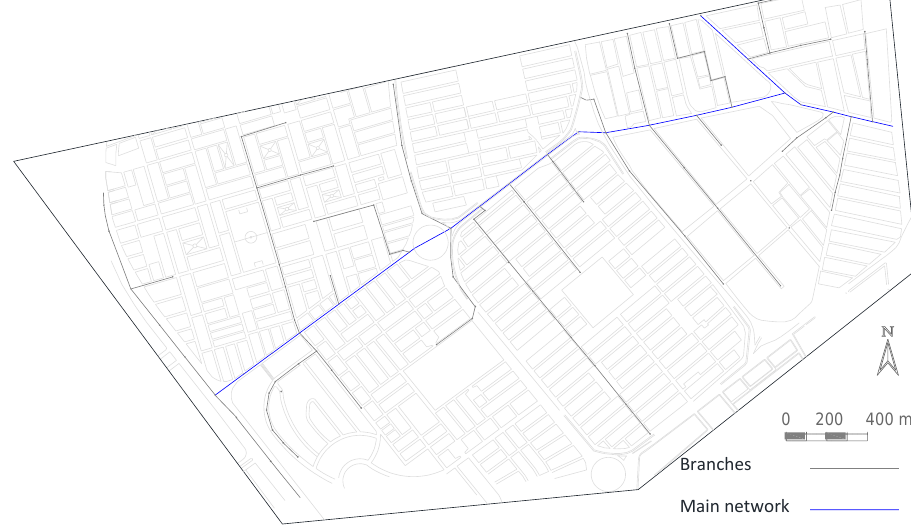
Figure 4. Drainage network with identification of branches and main